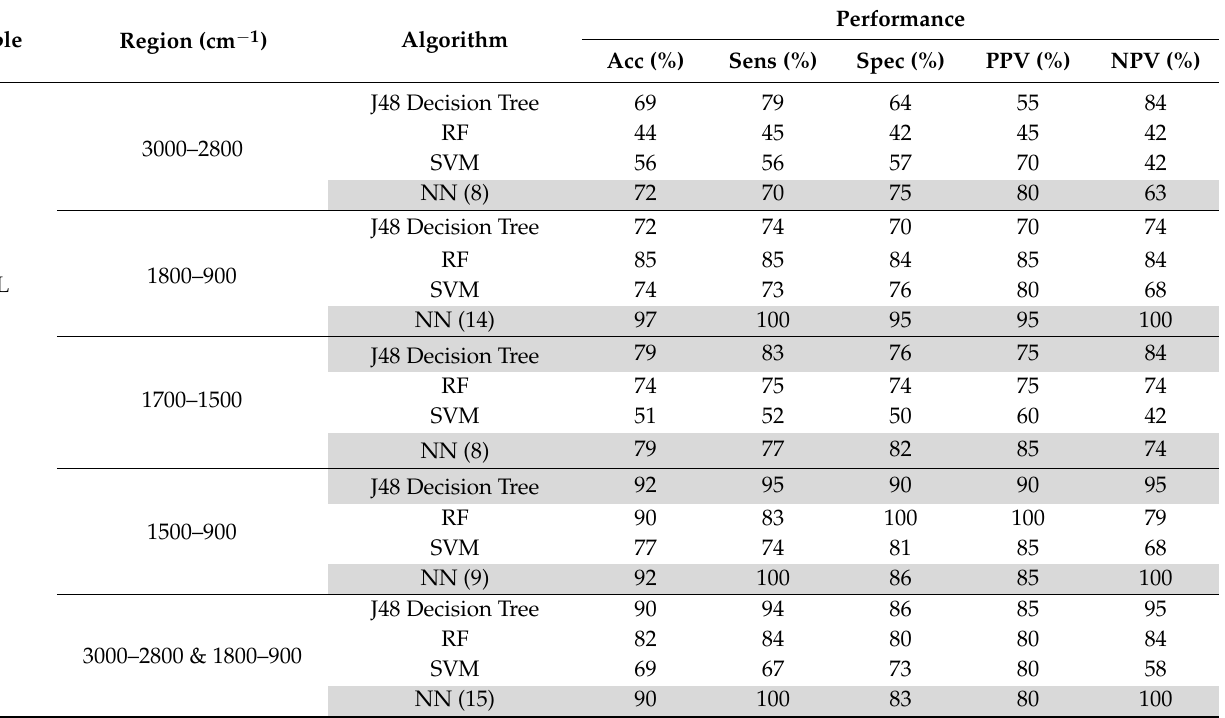
Table 4. Comparison of multiple advanced machine learning algorithms for classification models in HDL